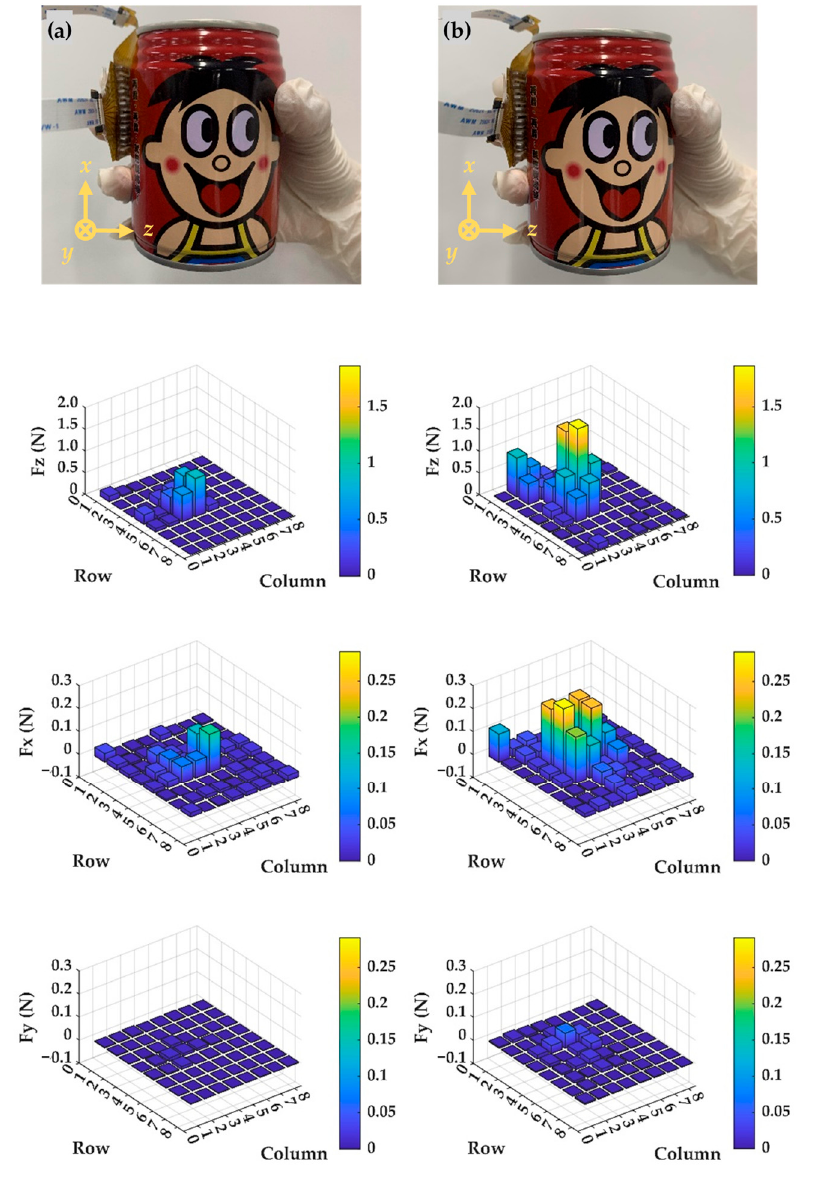
Figure 9. The measured contact force distribution with the sensing array mounted on two fingers: ( a ) When picking up an empty beverage can; ( b ) Grasping a full one.